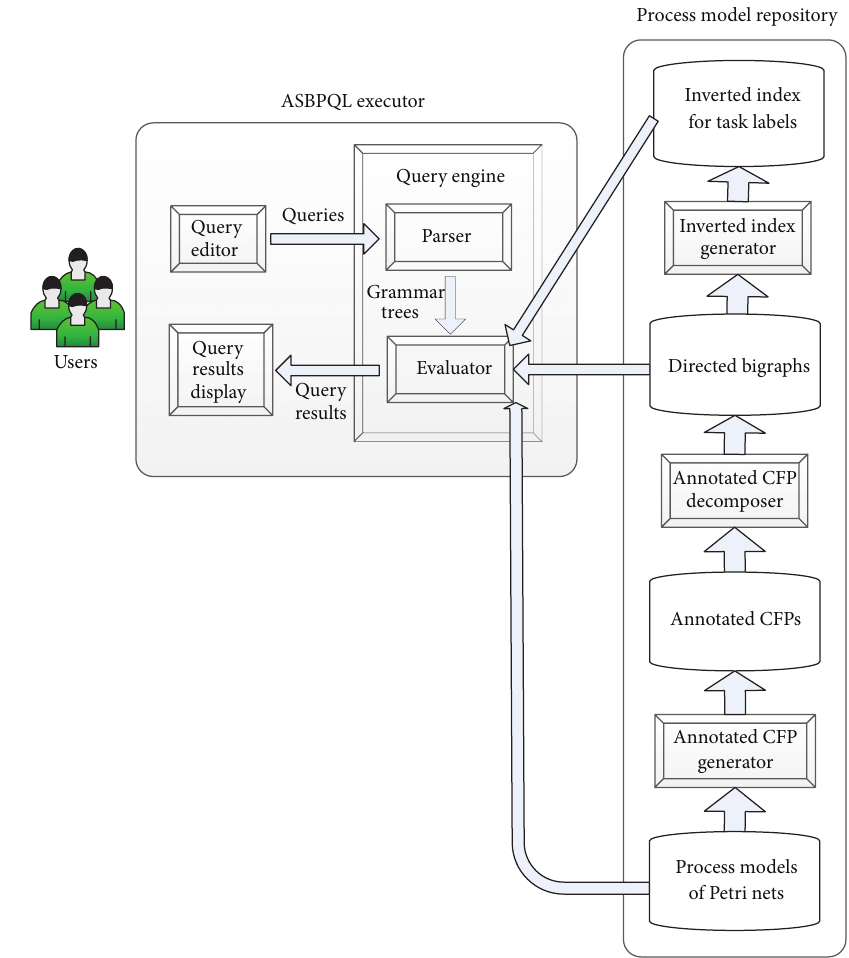
Figure 10: BeehiveZ: architecture of ASBPQL Querier and Process Models Repository.